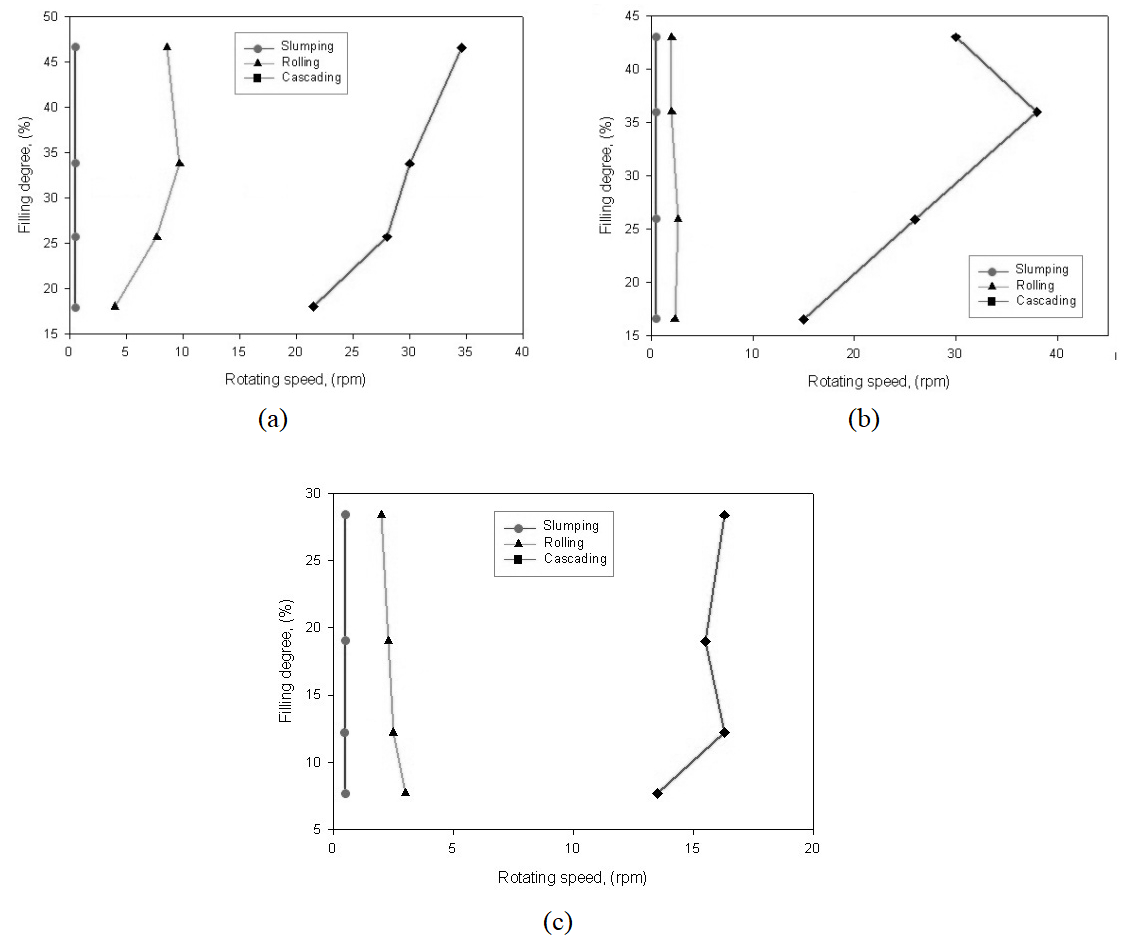
Fig. 4: Filling degree at different rotating speeds in slumping, rolling, and cascading modes for cylinders with diameters equal to (a) 15 cm, (b) 20 cm, and (c) 30 cm.